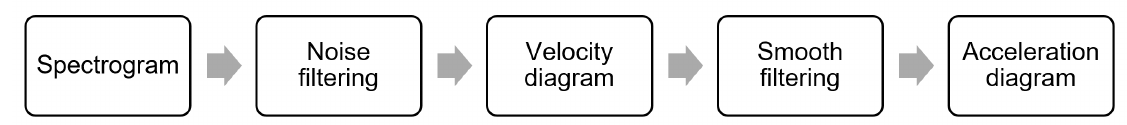
Figure 6. Block diagram of walking samples processing to obtain acceleration-time plots.